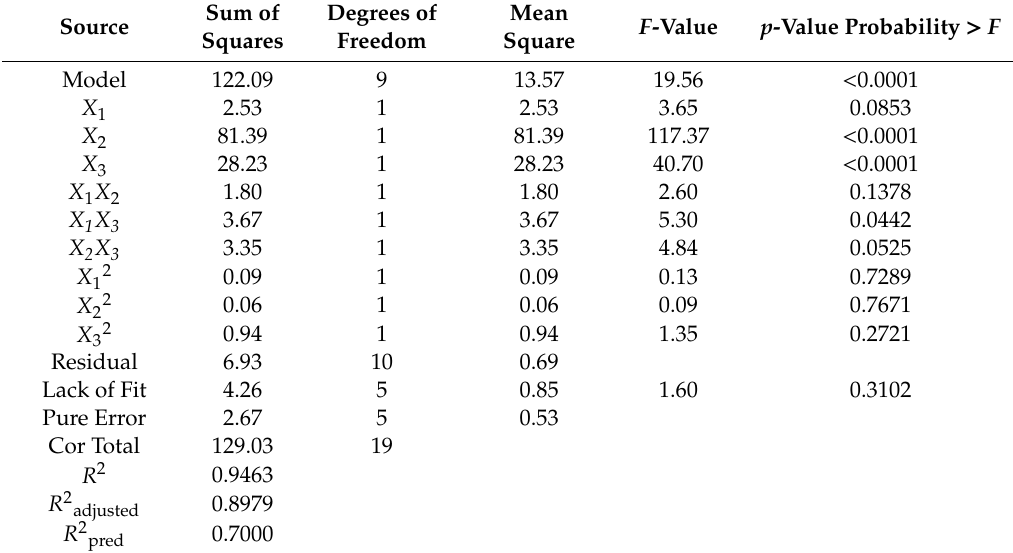
Table 2. ANOVA of the fitted quadratic polynomial model.